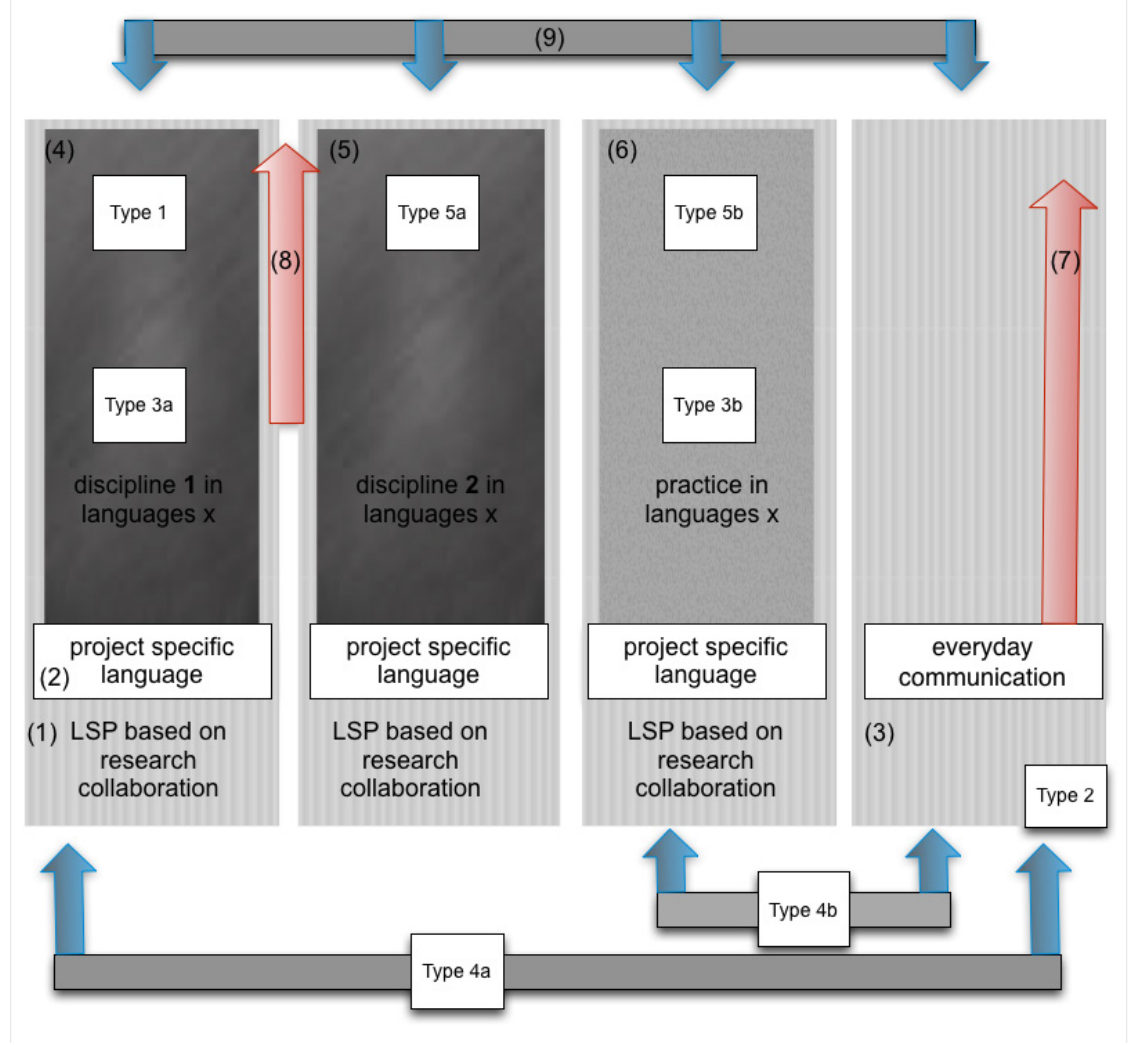
Fig. 12: transdisciplinary research project in the data collection phase Looking at the same research project at the data collection phase, the communication situations are different and for describing them, the full model as presented in figure 12 (and in figure 8) would be necessary. The project consists of members from different academic disciplines, as well as from outside academe. They communicate in heterogeneous groups (10) and in different dialogues (types 1, 3a, 5a, 5b and 3b). For data collection they also interact with individuals outside the project and from outside academia (type 4a and 4b) – as well as interacting with themselves (type